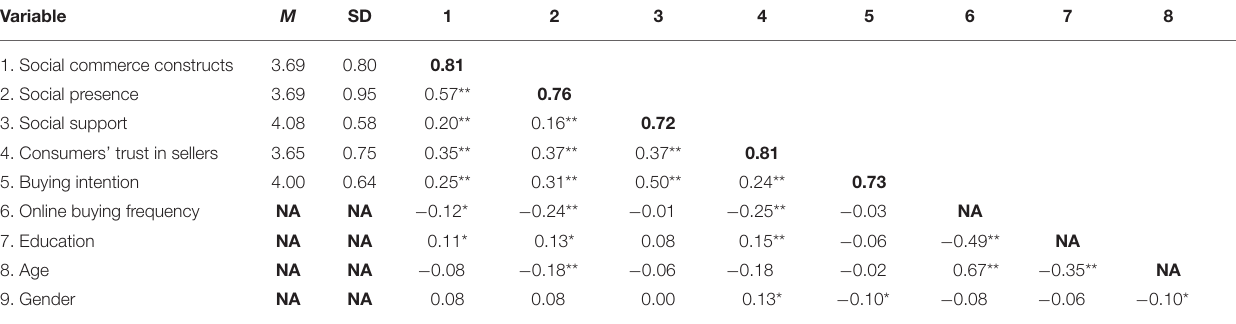
TABLE 3 | Means, standard deviation, and correlations. Variable